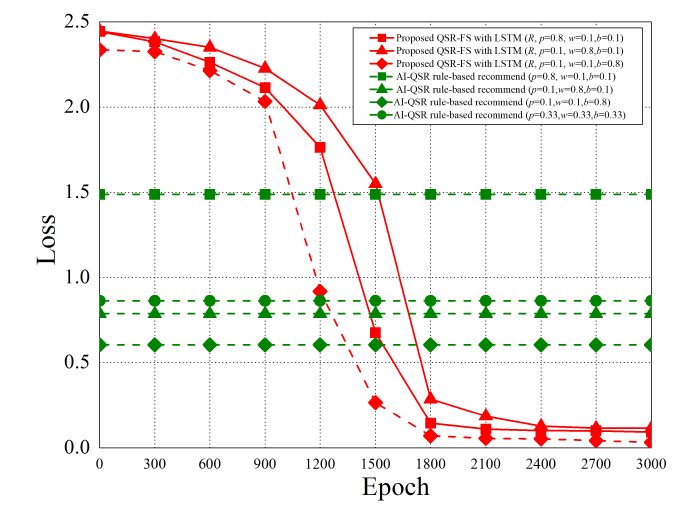
Figure 17. Categorical cross-entropy loss vs. per epoch.